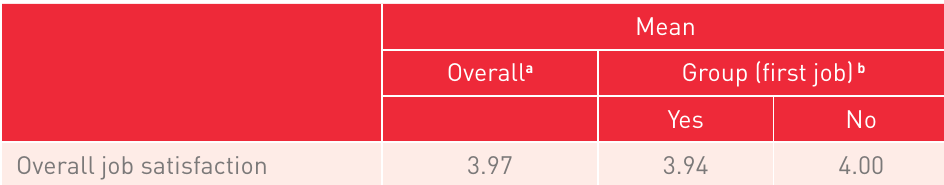
The respondents’ overall job satisfaction